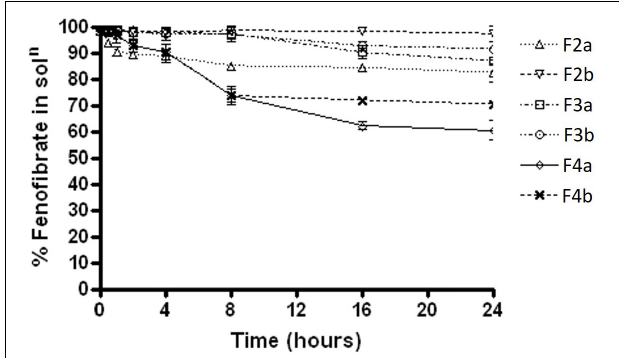
FIGURE 4 | The % fenofibrate in solution during 24 h time after 1:100 dilution in the simulated fasted state intestinal media (fenofibrate was dissolved at 80% of the equilibrium solubility in the anhydrous mixture). The formulation represent F2a- C70: CM (7:3)/TO106V (1/1), F3a- C70: CM (7:3)/ HCO-30 (1/1), F2b- K70:I742(7:3)/TO106V(1/1), F3b- K70:I742(7:3)/ HCO-30 (1/1), F4a- CMCM/HCO-30 (1/1) and F4b- I742/ HCO-30 (1/1) respectively. Data are presented as mean ± SD, ( n =